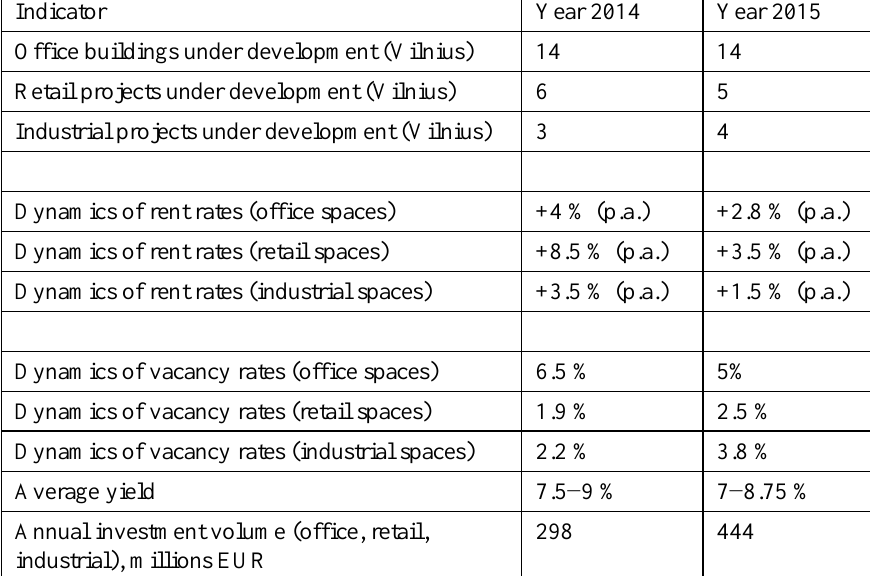
Table 2. Market indicators of Vilnius commercial property market in 2014 and 2015 (Colliers International, 2015, 2016, table made by